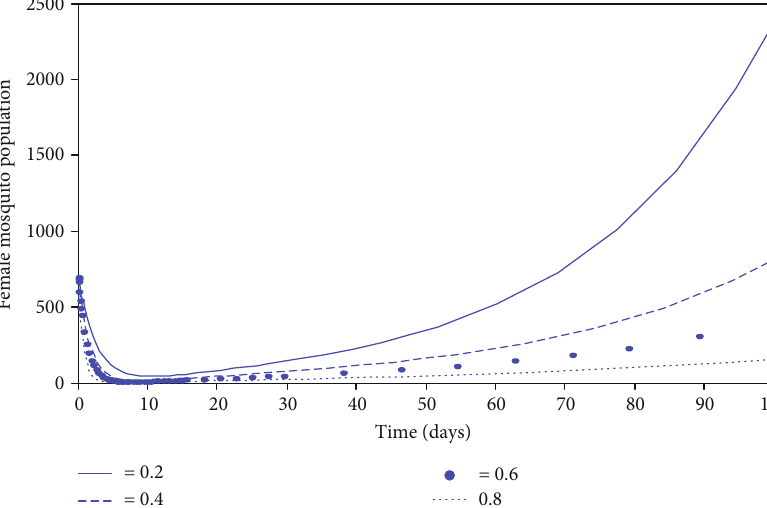
Figure 1: Impact of female mosquito mating probability ð ρ s Þ to be with the sterile male on the female mosquitoes; as this rate increases, the population of the female mosquitoes is reduced.